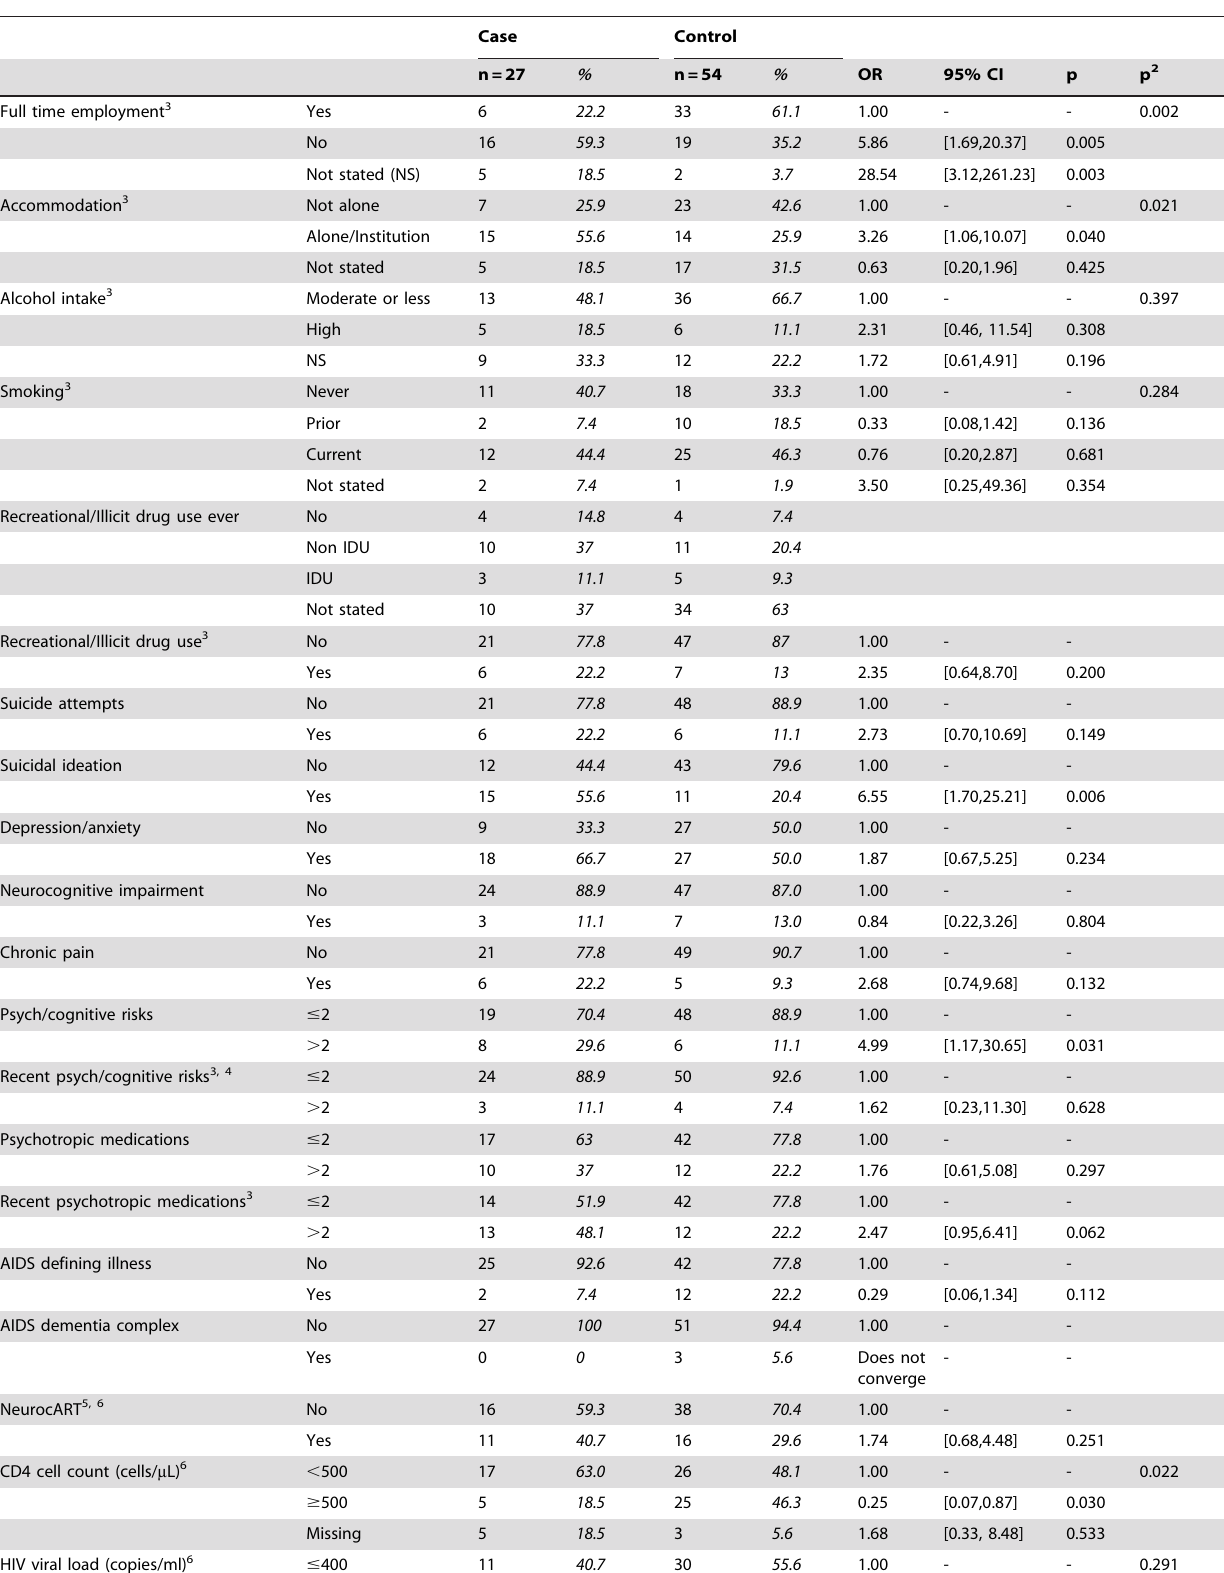
Table 2. Patient characteristics prior to case death and risk of suicide and accidental/violent death 1